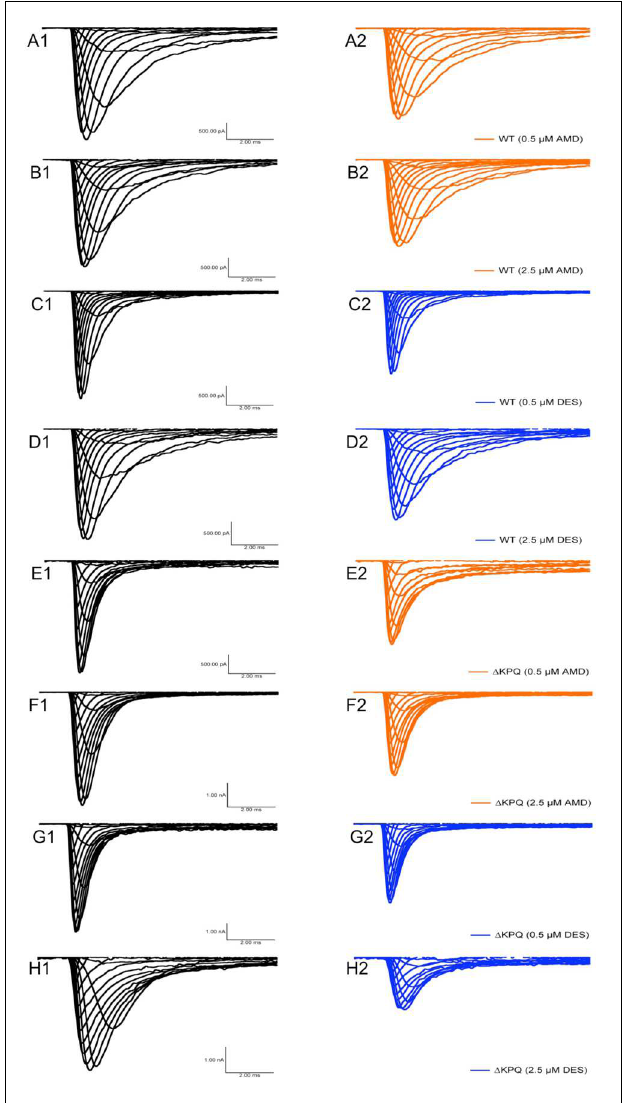
FIGURE 2 | Current amplitude plotted versus time duration. The traces show the variation in current levels before and after AMD and DES